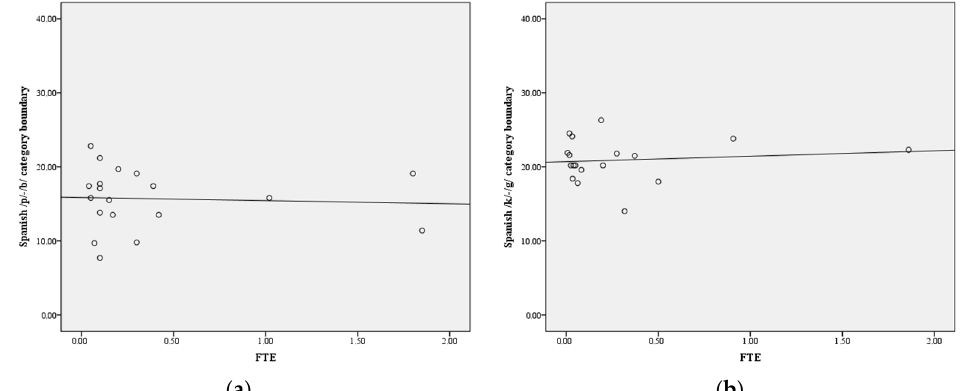
Figure 1. Scatterplots with fit lines for FTE ( x axis) and category boundary ( y axis) in English by the English learners of Spanish. ( a ) Category boundary for the /p/–/b/ contrast in English. ( b ) Category boundary for the /k/–/g/ contrast in English.